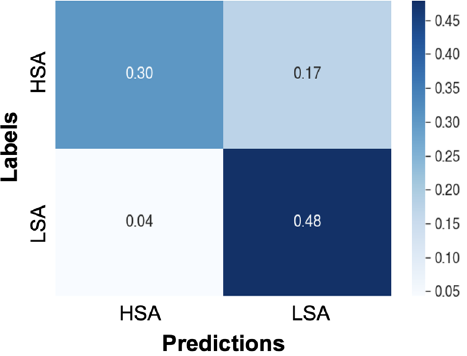
Figure 3. Confusion matrix of the extreme gradient boosting (XGBoost) model prediction. Annotations of each box represents the ratio of samples in that category.